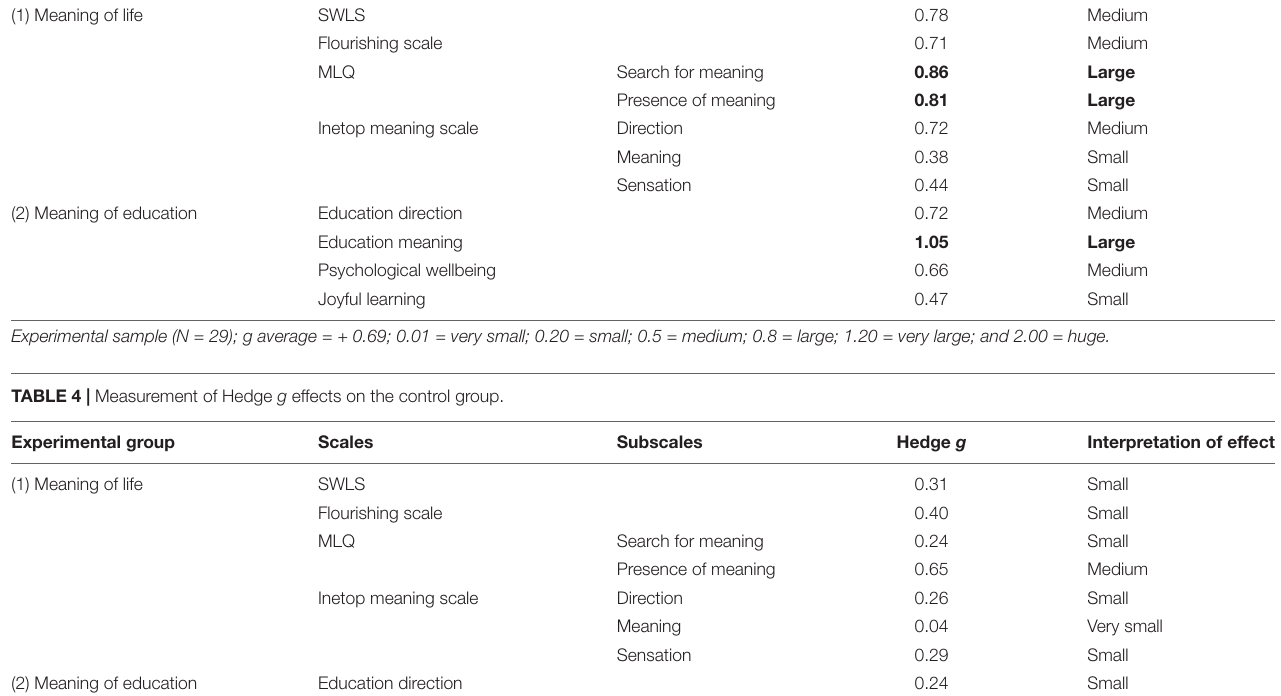
TABLE 3 | Measurement of Hedge g effects on the experimental group. Experimental group Scales